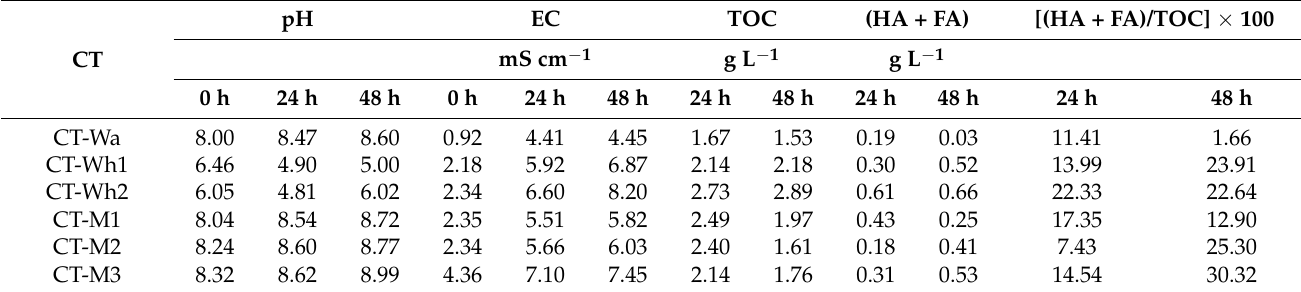
Table 3. pH and electrical conductivity (EC) measured in the CTs during the extraction process (at 0 h, after 24 h, after 48 h). Comparison between total organic carbon (TOC, g L − 1 ), humic and fulvic acids (HA + FA, g L − 1 ), and humic and fulvic acids to TOC ratio [(HA + FA)/TOC] × 100, measured after 24 and 48 h from the start of the extraction